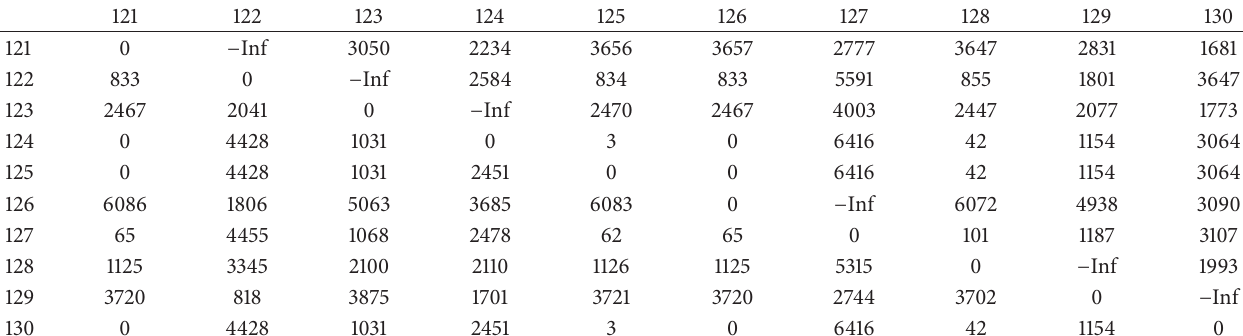
Table 5: The distance matrix in first stage.